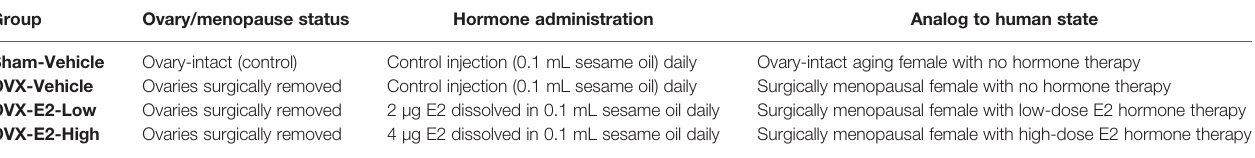
TABLE 1 | Experimental group condition descriptions and